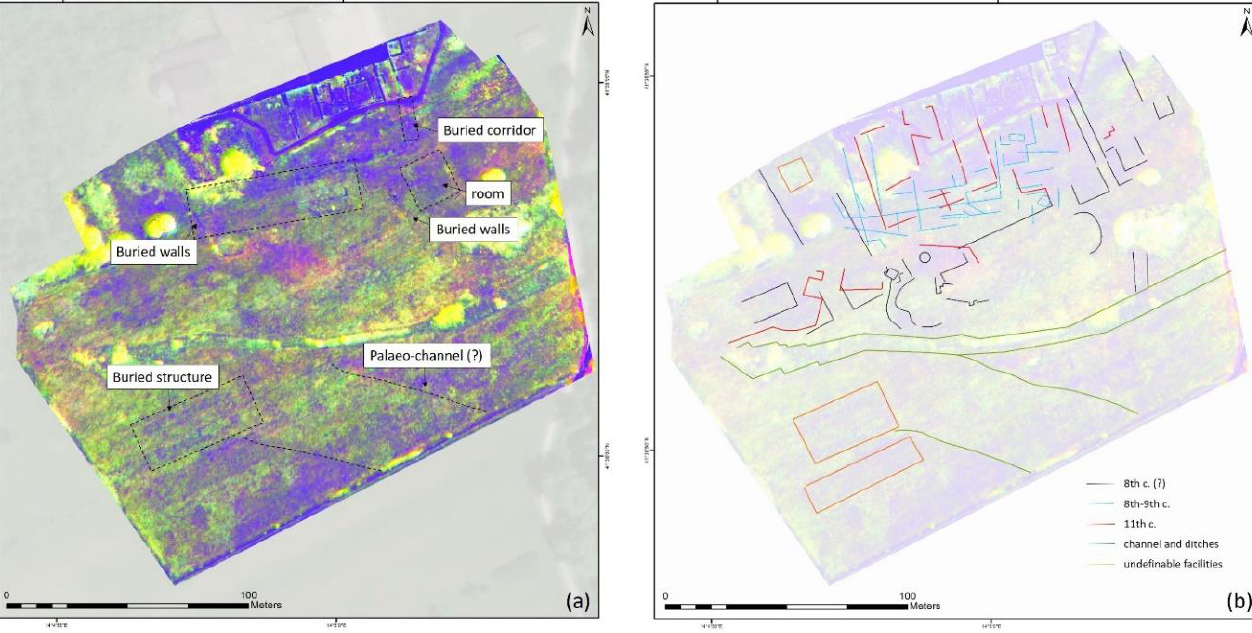
Figure 15. SPCA and identified features and hypothesis: ( a ) example of FoAIs; ( b ) identified FoAIs.